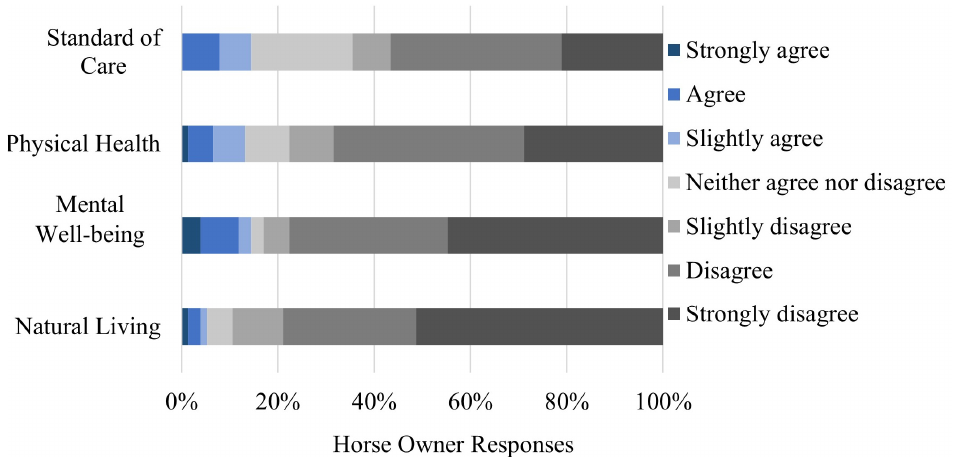
Figure 2. Owners’ level of agreement with horses’ welfare being better when housed individually versus in groups. versus in